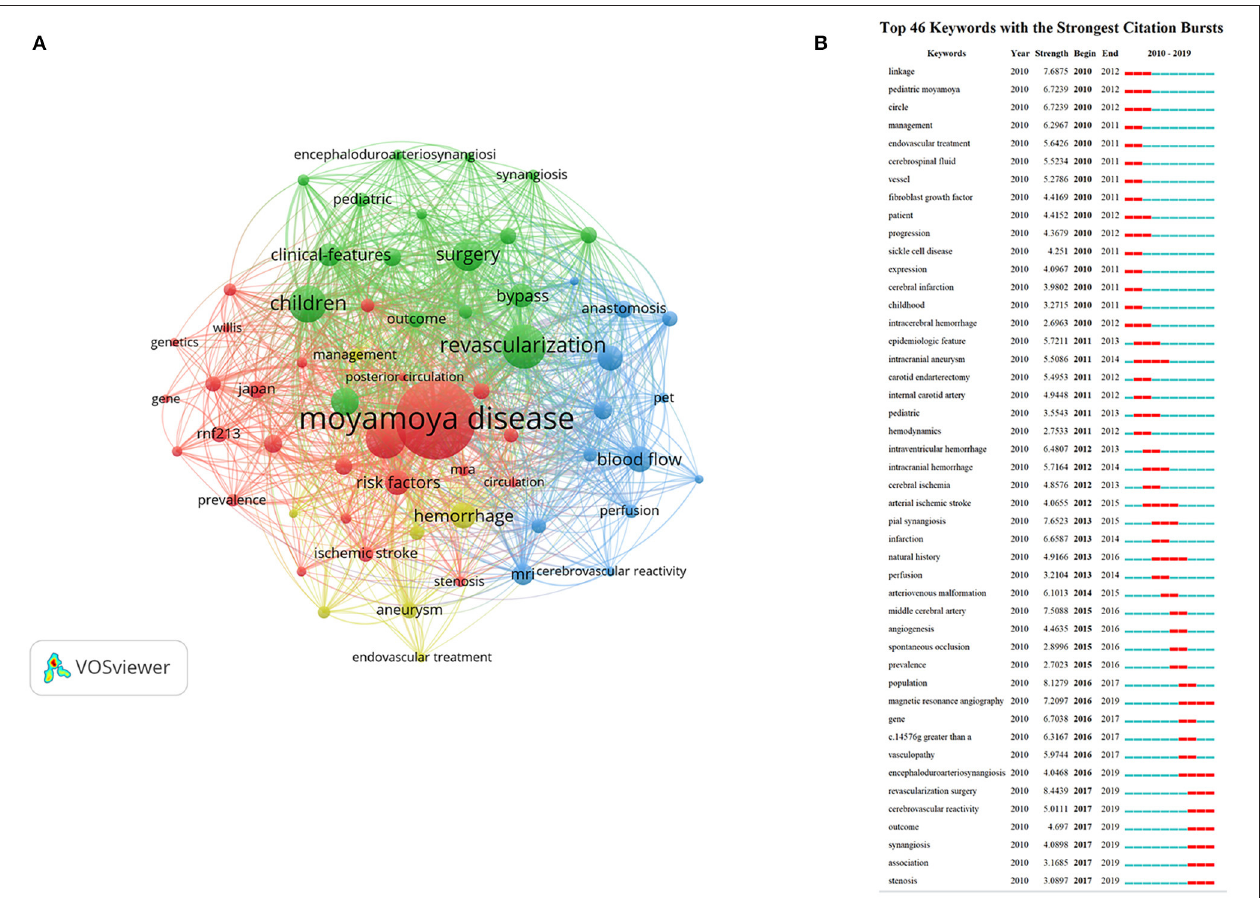
FIGURE 7 | (A) The co-occurrence network visualization map of keywords in the MMA research field from 2010 to 2019. Keywords in the same color represent were sorted into the same cluster. (B) The top 46 keywords with the strongest citation bursts on MMA research between 2010 and 2019. The red segment of the blue line denoted the burst duration of a